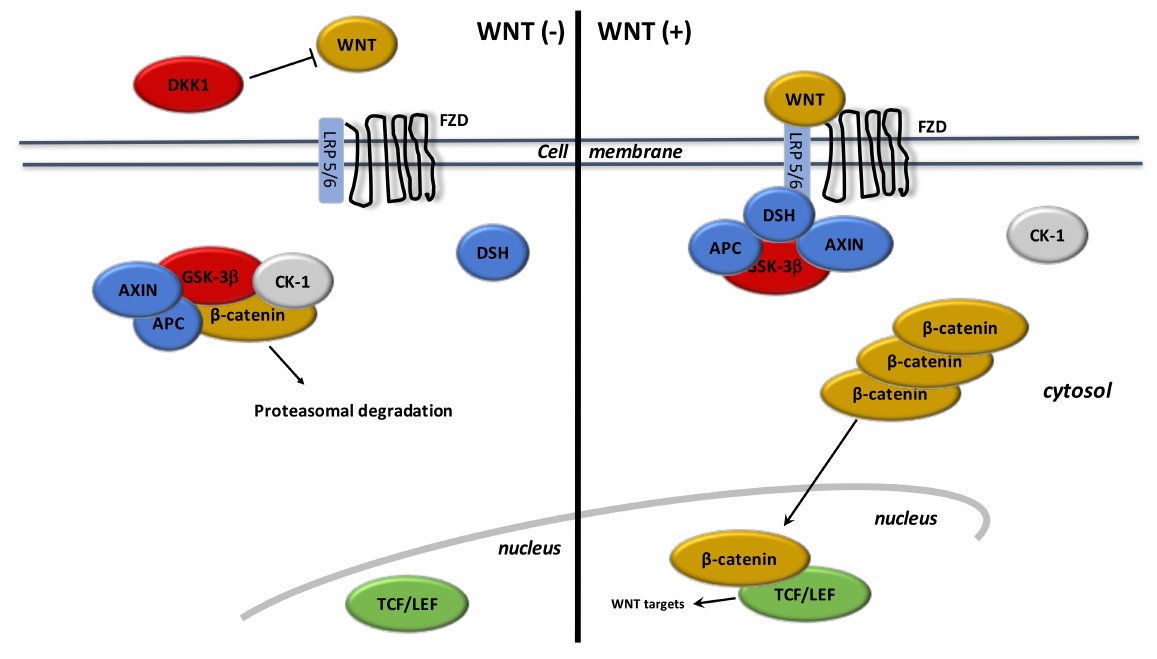
Figure 2. The canonical WNT / β -catenin pathway. WNT ( − ). Under physiologic circumstances, the cytoplasmic β -catenin is linked to its destruction complex, consisting of APC, AXIN, and GSK-3 β . After CK-1 phosphorylates on Ser45 residue, β -catenin is phosphorylated on Thr41, Ser37, and Ser33 residues by GSK-3 β . Thus, phosphorylated β -catenin is destroyed into the proteasome. Then, cytoplasmic level of β -catenin is kept low in the non-presence of WNT ligands. If β -catenin is not accumulated in the nucleus, the TCF / LEF complex does not stimulate the target genes. DKK1 inhibits the WNT / β -catenin pathway through the bind to WNT ligands or LRP5 / 6. WNT ( + ). When WNT ligands activate both FZD and LRP5 / 6, DSH is stimulated and phosphorylated by FZD. Phosphorylated DSH in turn activates AXIN, which comes o ff β -catenin destruction complex. Thus, β -catenin escapes from phosphorylation and then accumulates in the cytoplasm. The accumulated cytosolic β -catenin moves into the nucleus, where it interacts with TCF / LEF and stimulates the transcription of target